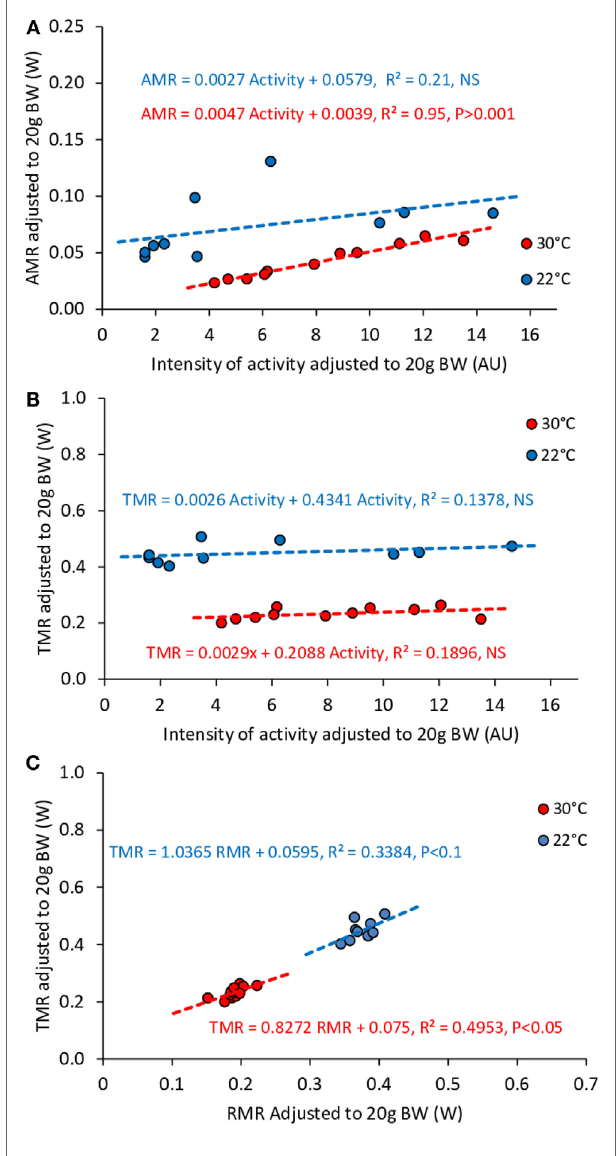
FigUre 10 | correlation between aMr and activity (a), TMr and activity (B), TMr and rMr (c) in fasting mice housed at 30°c ( n = 11) and 22°c ( n = 10) . Data were adjusted to 20 g BW. The small ranges of activity, TMR, and RMR values in fasting mice prevented results